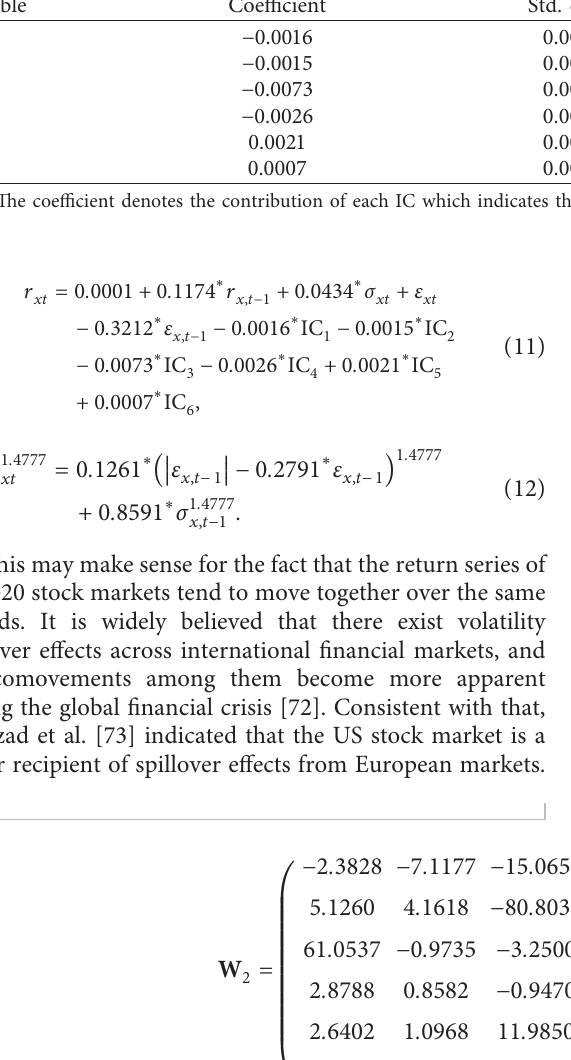
Table 3: The results estimated by the ICA-based ARMA-APARCH-M model for cluster 1. Variable